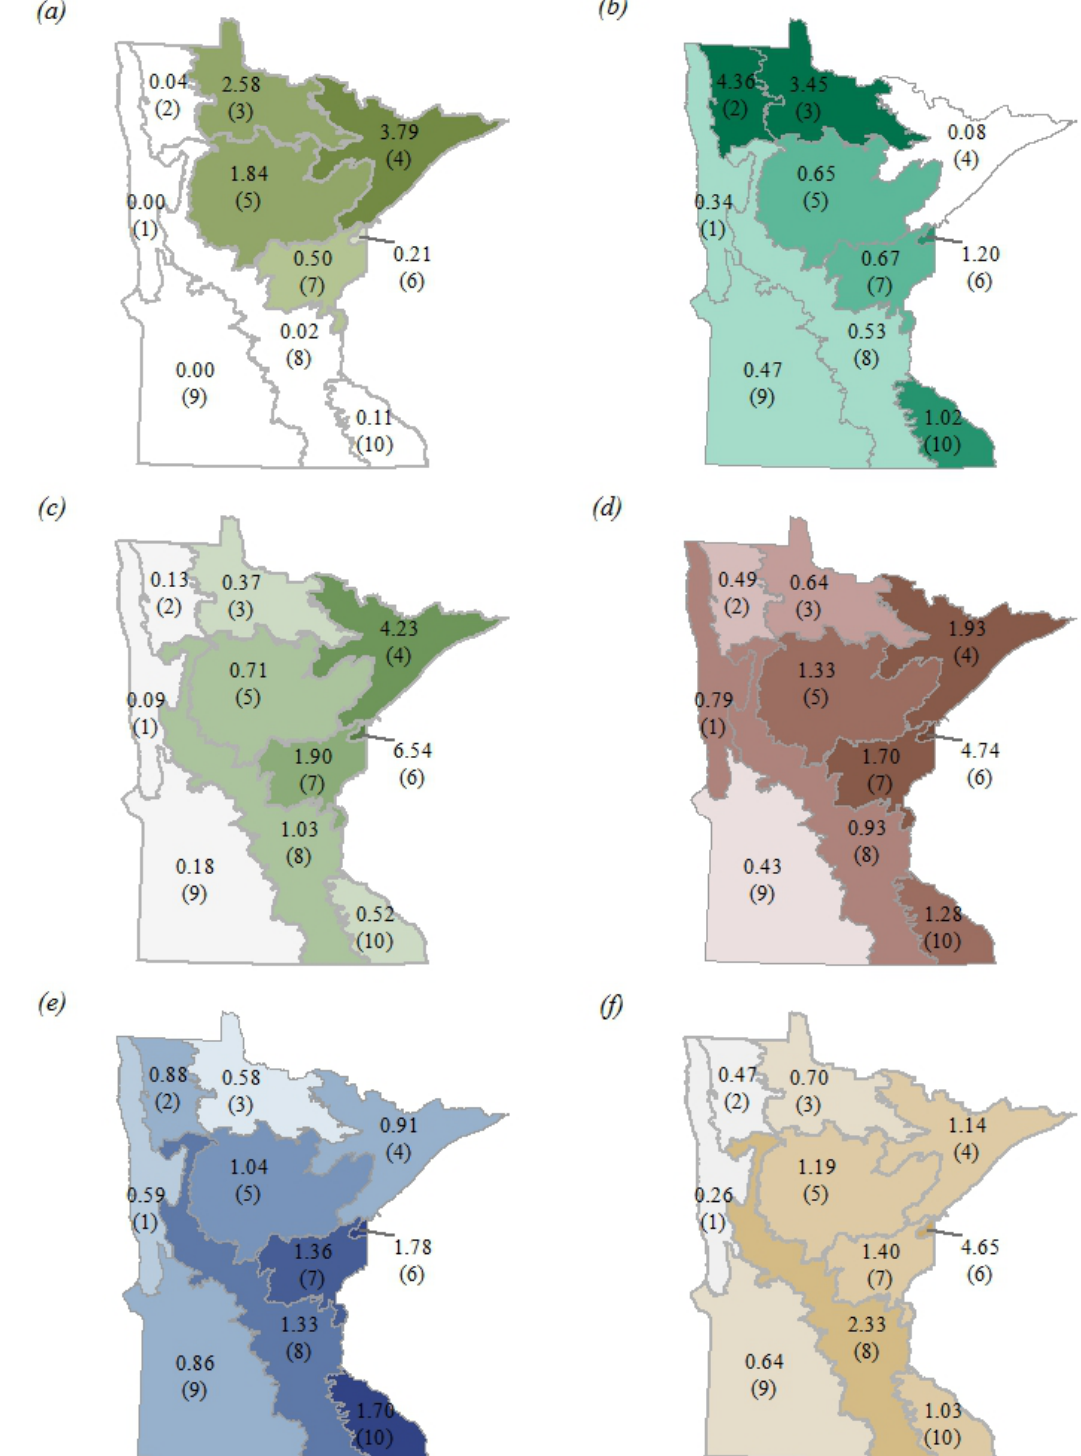
Figure 2. Area based RLQs for ( a ) forestland, ( b ) nature preserve, ( c ) parkland, ( d ) summer trails, ( e ) winter trails, and ( d )